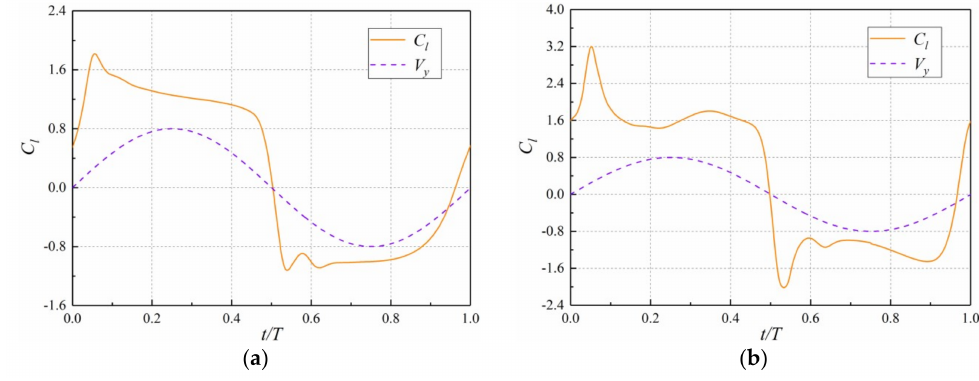
Figure 11. C l curves of upper foil under different K θ at k = 0.8: ( a ) K θ = 1; ( b ) K θ = 2.